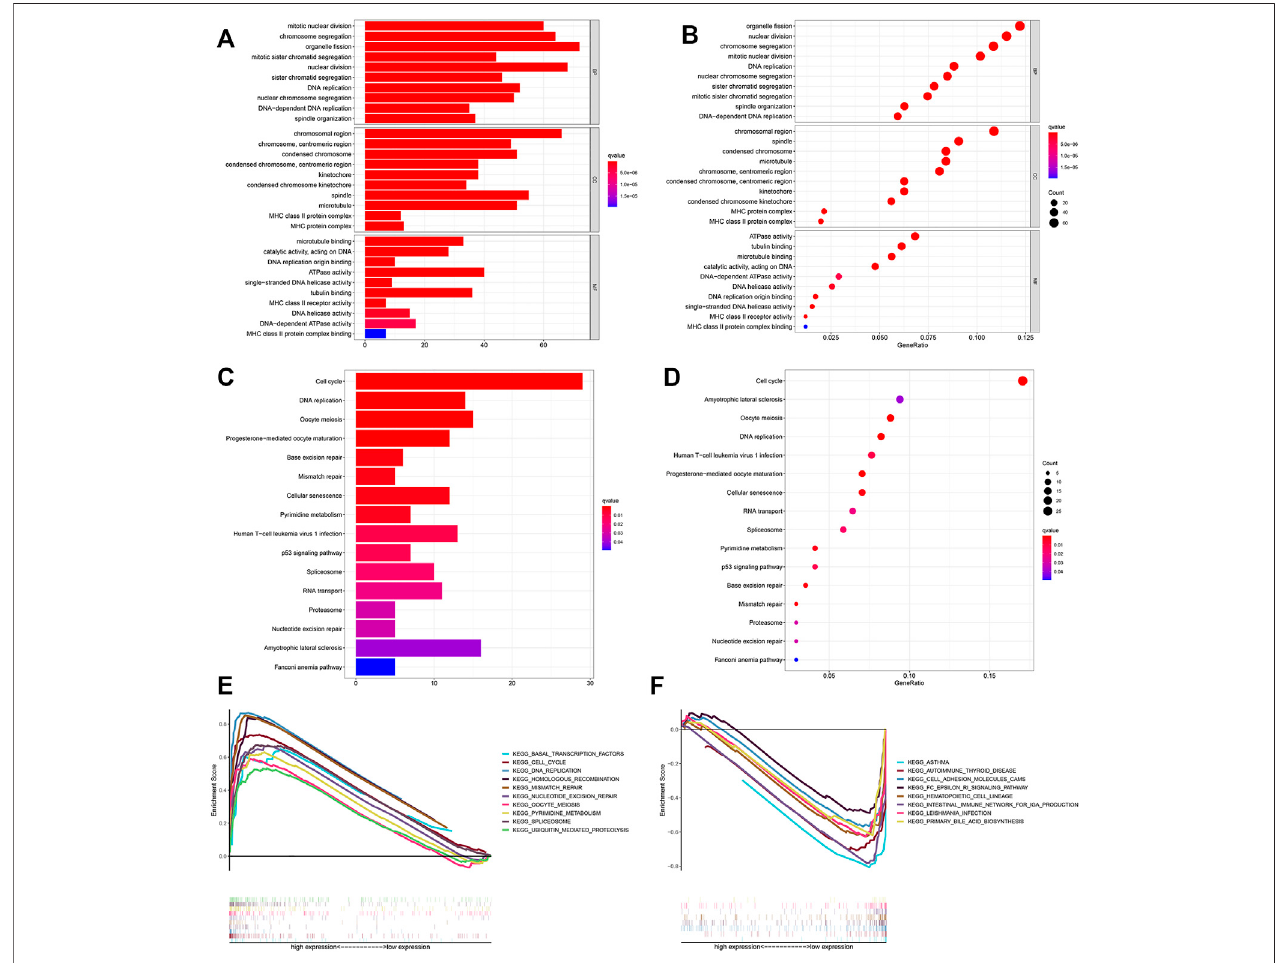
FIGURE 7 | Functional analysis. Bubble and barplot graph for (A,B) KEGG pathways and (C,D) GO enrichment based on the DEGs in the training cohort. (E,F) KEGG pathways of GSEA analysis.